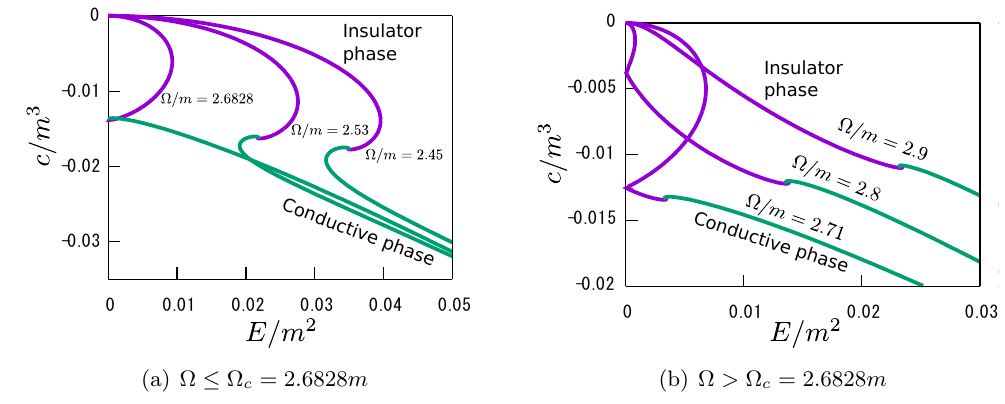
Figure 9 . Quark condensates as functions of the electric (cid:12)eld for (cid:12)xed several (cid:10). The left and right panels are for below and above critical frequency. The purple and green curves are for insulator and conductive phases,